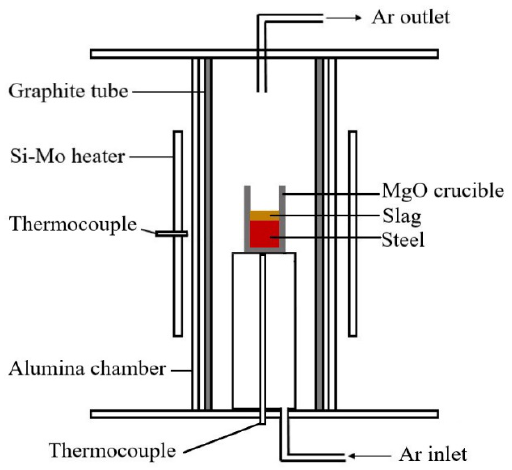
Figure 1. Schematic of experimental set-up.